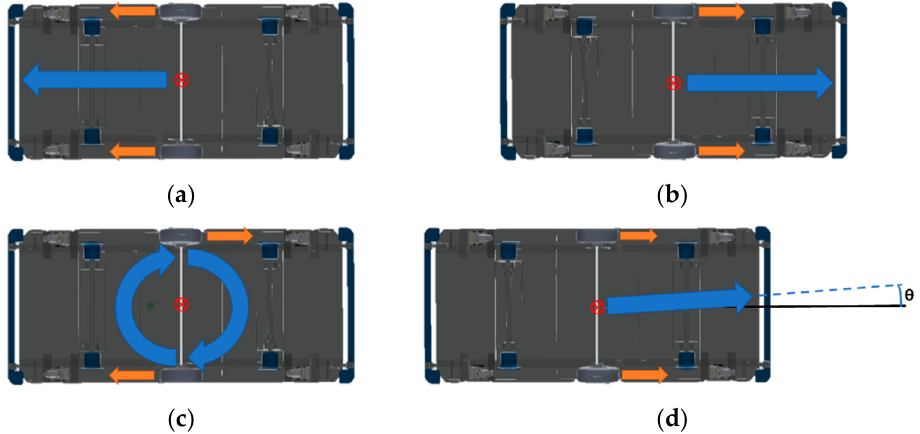
Figure 13. The proposed robot movement. ( a ) forward move; ( b ) backward move; ( c ) rotation in place; ( d ) rotation by the angle θ .